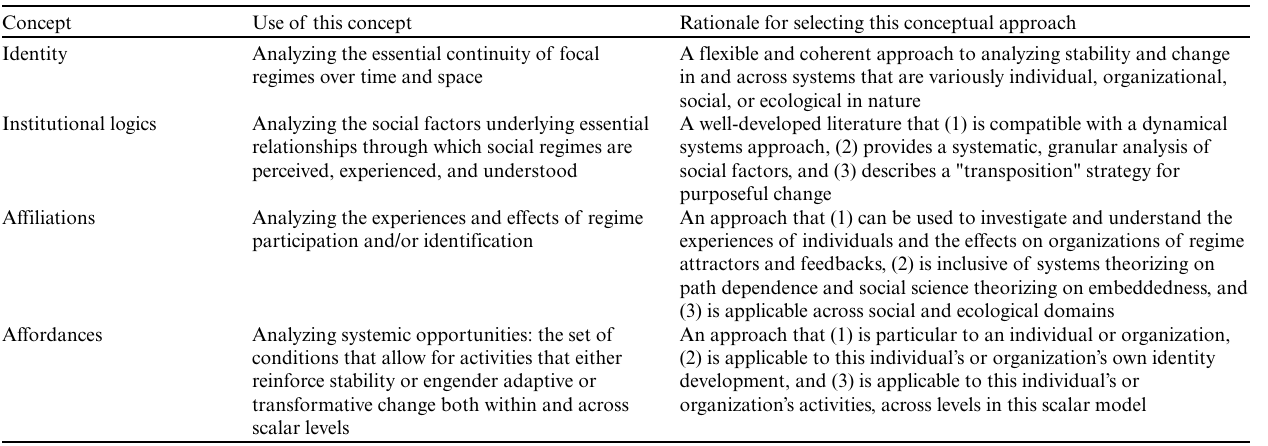
Table 1 . Framework of key concepts used in analyzing the dynamics of a scalar model that links the individual level with the ecological.